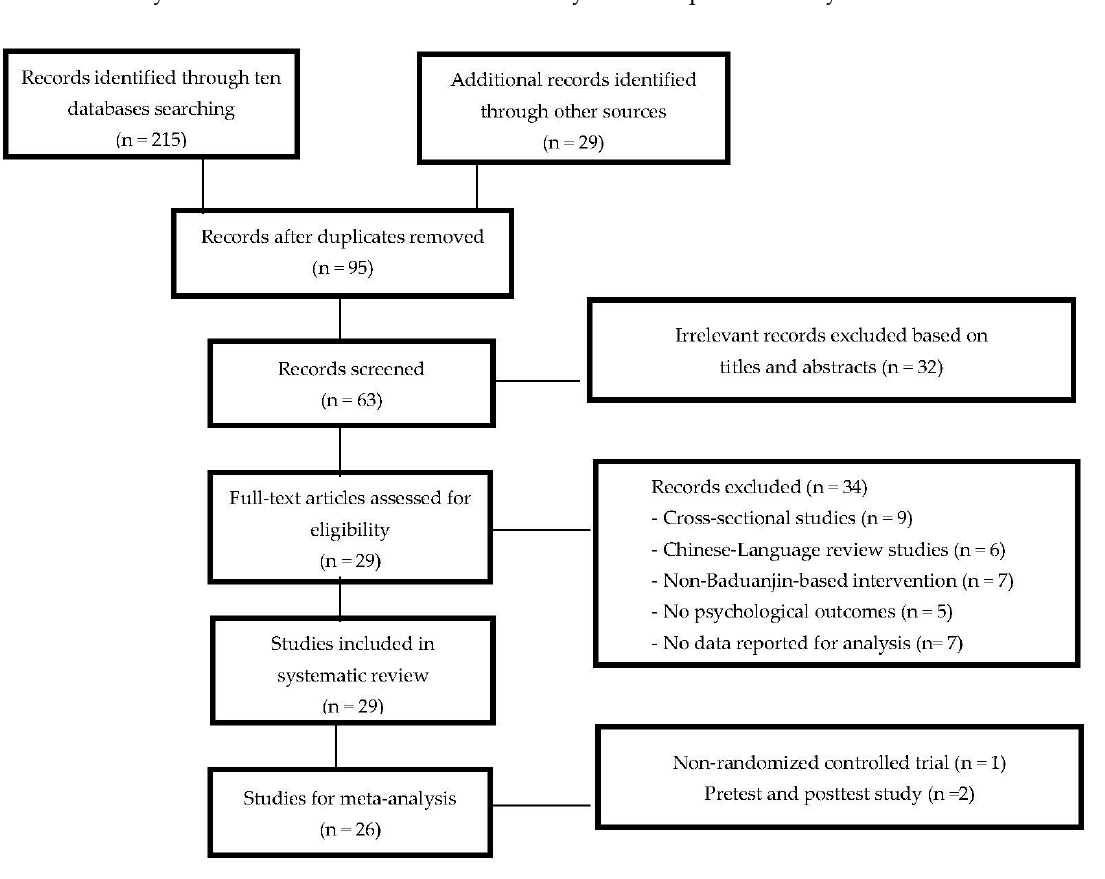
Figure 1. The flow of our literature search and selection process.